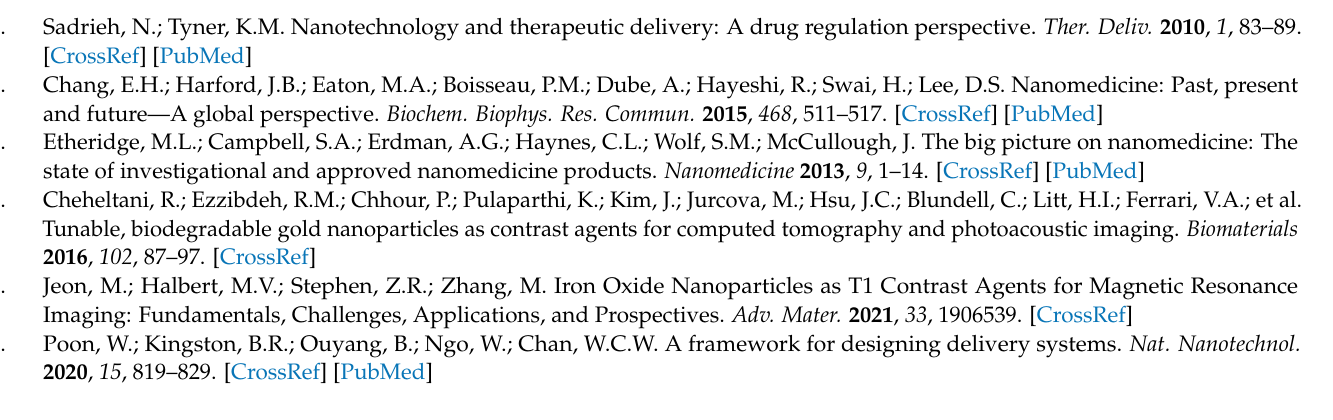
DHM QPI images in gray level representation of RAW 264.7 macrophages and NIH-3T3 fibroblasts; Figure S5: Representative DHM QPI images in gray level representation of NRK-52E cells and RLE- 6TN cells; Figure S6: Temporal dry mass development of cell populations with standard deviations; Figure S7: Temporal dry mass development of cell populations with standard deviation for